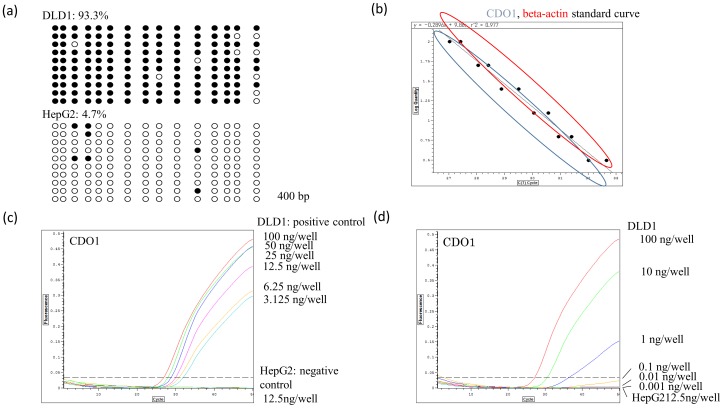
Q-MSP analysis of CDO1 methylation and analysis of the PCR reaction.(a) Sequence analysis of the cloned CDO1 promoter. The frequency of methylated CpG islands in the cloned CDO1 promoter from the positive control, DLD1 cells, and the negative control, HepG2 cells. (b) Q-MSP efficacy for PCR amplification of CDO1 and β-actin was excellent. (c) Sensitivity of CDO1 methylation detection using Q-MSP was assayed using 2-fold dilutions (from 100 to 3.125 ng/PCR) of cloned CDO1 promoters from DLD1 and HepG2 cells. (d) Q-MSP of CDO1 methylation in in DLD1 cells using 10-fold dilutions (100, 10, 1, 0.1, and 0.01 ng/PCR) of the cloned CDO1 promoter. A concentration as low as 1 ng/PCR reaction of the positive control DLD1 cell DNA can be clearly detected. However, DNA at 1000 fold dilution (0.1 ng/PCR) can be barely be detected. Note that detection is less sensitive when lower amounts of DNA are applied.